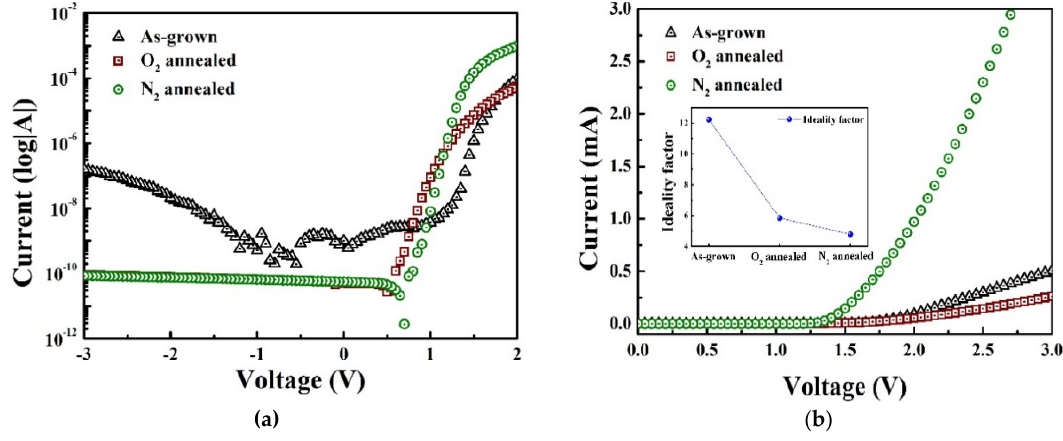
Figure 6. I–V characteristics of diodes at room temperature: ( a ) log-scale and ( b ) linear